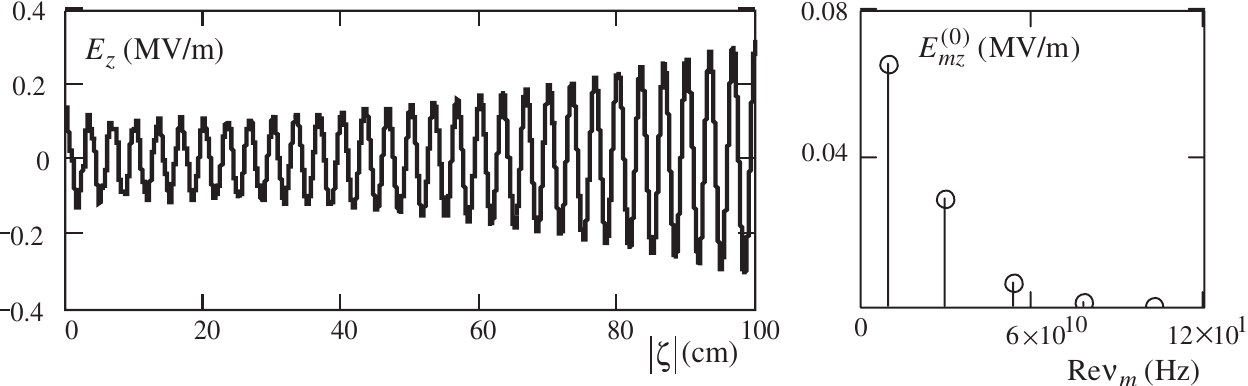
FIG. 4. Longitudinal component of the electric field E amplitudes of the harmonics E (cid:2) 0 (cid:3) mz at (cid:2) (cid:4) 0 . (right) ( (cid:4) (cid:4) 1 mm , q (cid:4) (cid:1) 1 nC , (cid:11) (cid:4) 22 : 37 , (cid:6) (cid:4) 0 : 999 , Im " (cid:4) 0 : 02 , a (cid:4) 2 cm , b (cid:4) 1 : 405 cm ).